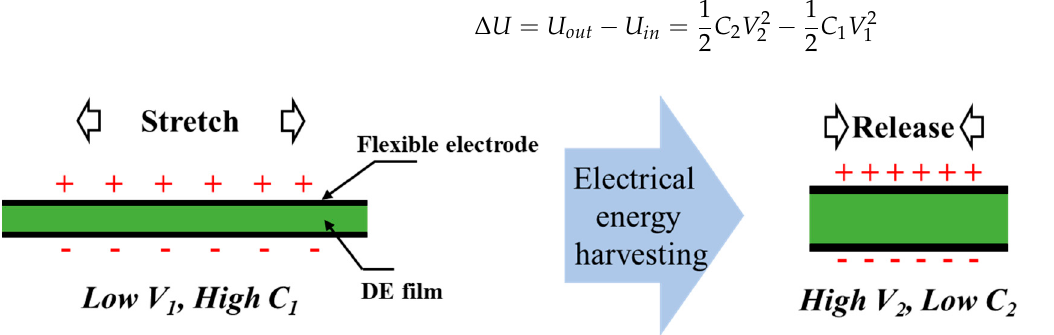
Figure 1. Schematic diagram of the working principle of the DEG. Mechanical energy is converted into electrical energy by releasing a stretched and charged DE film.